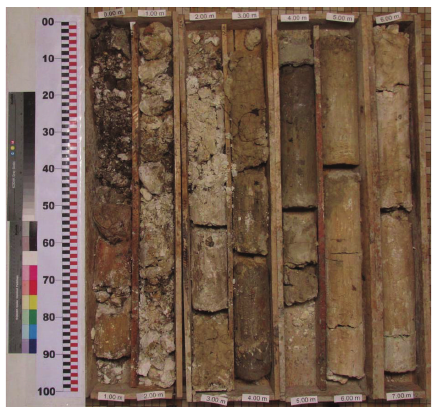
Figure 3: Soil samples obtained from the coring S1 on the crest of the